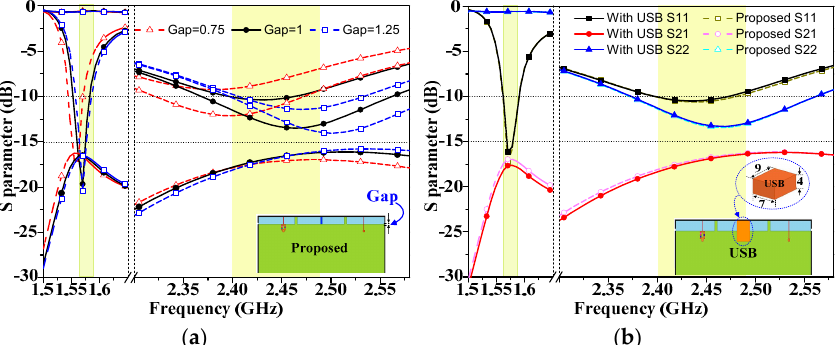
Figure 6. Simulated S parameter for the proposed antenna ( a ) as a function of Gap width, and ( b ) with a USB